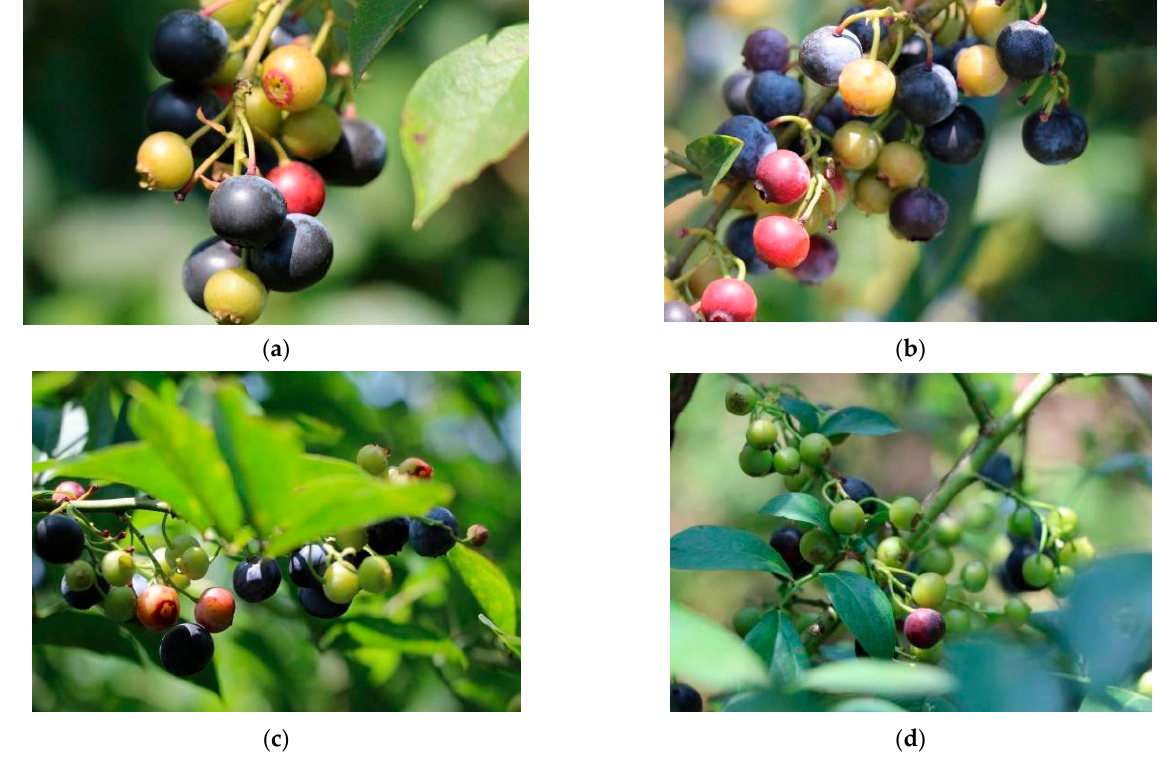
Figure 2. Collection of pictures. ( a ) Dense adhesions; ( b ) severely occluded; ( c ) branches and leaves cover; ( d ) complex background.